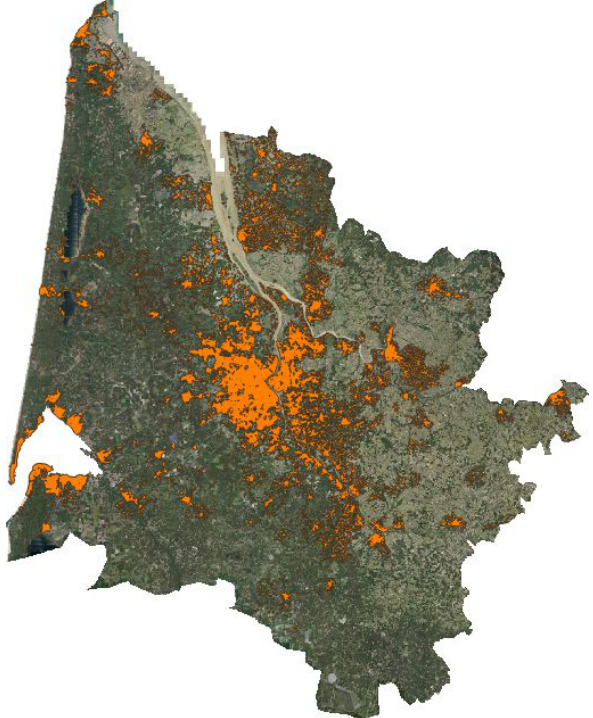
Figure 5. Urban areas of Gironde